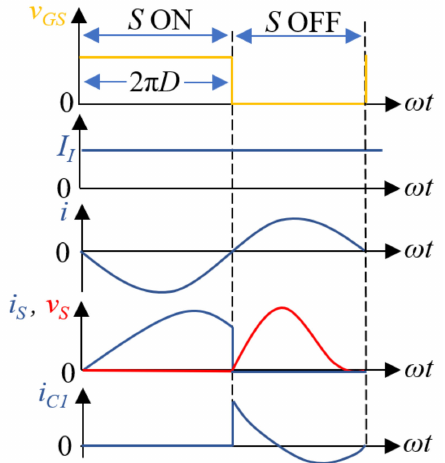
Figure 5. Waveforms in Class-E zero-voltage-switching inverter for optimum